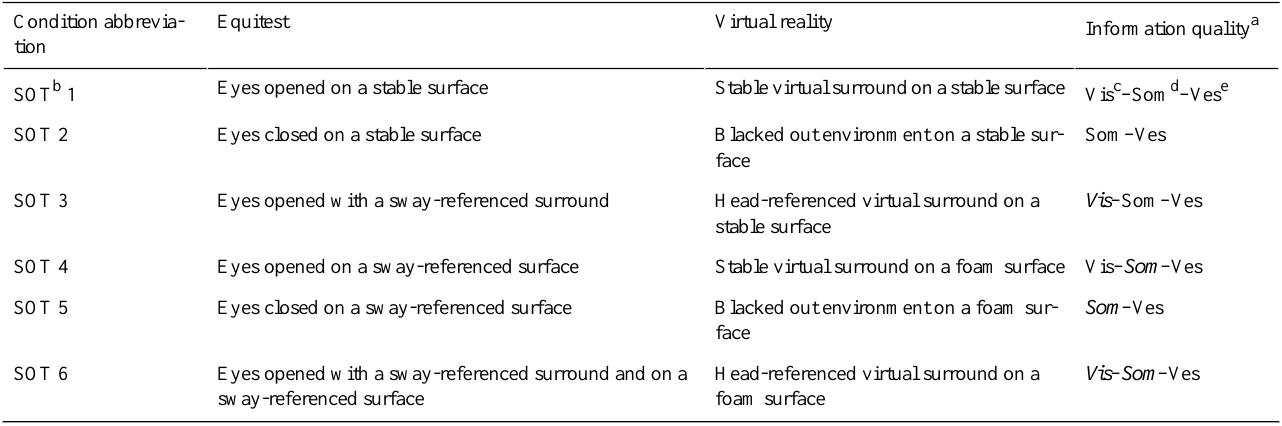
Table 2. Summary of all testing conditions, their abbreviations, and the quality of visual, somatosensory, and vestibular information available in the